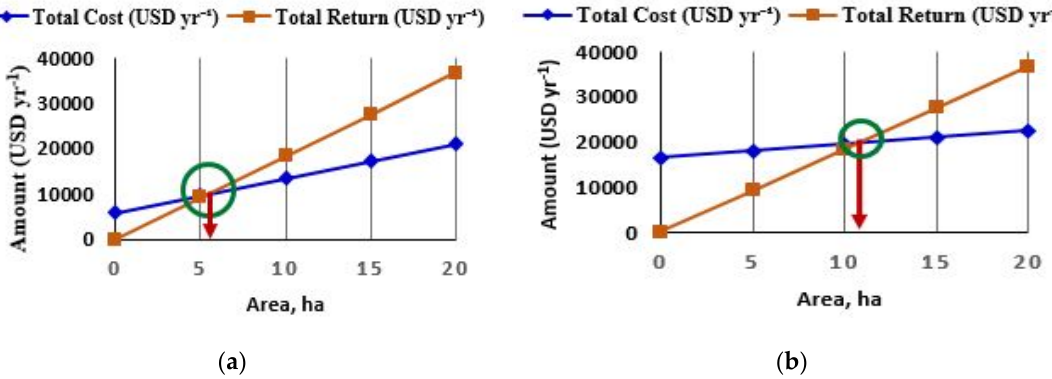
Figure 8. Break-even use analysis for ( a ) medium combine and ( b ) large combine.